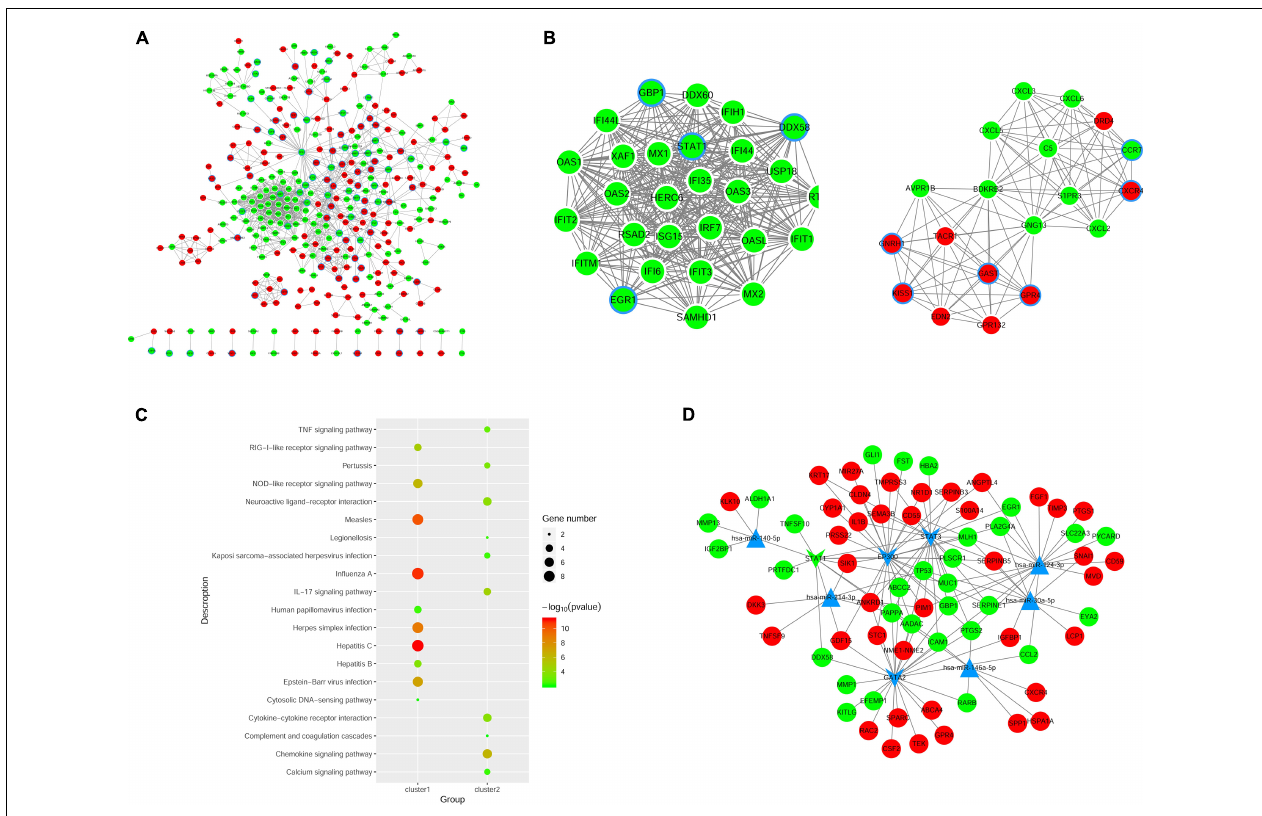
FIGURE 4 | Regulatory network analysis to predict miRNAs and TFs associated with ovarian cancer. (A) PPI network construction to analyze DEGs in shNTPCR ovarian cancer groups. The red node represent upregulated genes, while the green dot refer to downregulated genes. The node with blue aperture indicates genes related to ovarian carcinoma. (B) Two clusters of functional modules were identified from the PPI network. (C) Functional enrichment analysis results for DEGs in subnetwork modules, and the top 10 pathway categories were sorted according to the p -value. (D) Regulatory network of miRNA–TF–gene was constructed to predict crucial genes correlated with ovarian cancer progression. Dots in red and green color represent upregulated and downregulated genes, respectively; triangular nodes and V-shaped nodes represent miRNA and TFs.